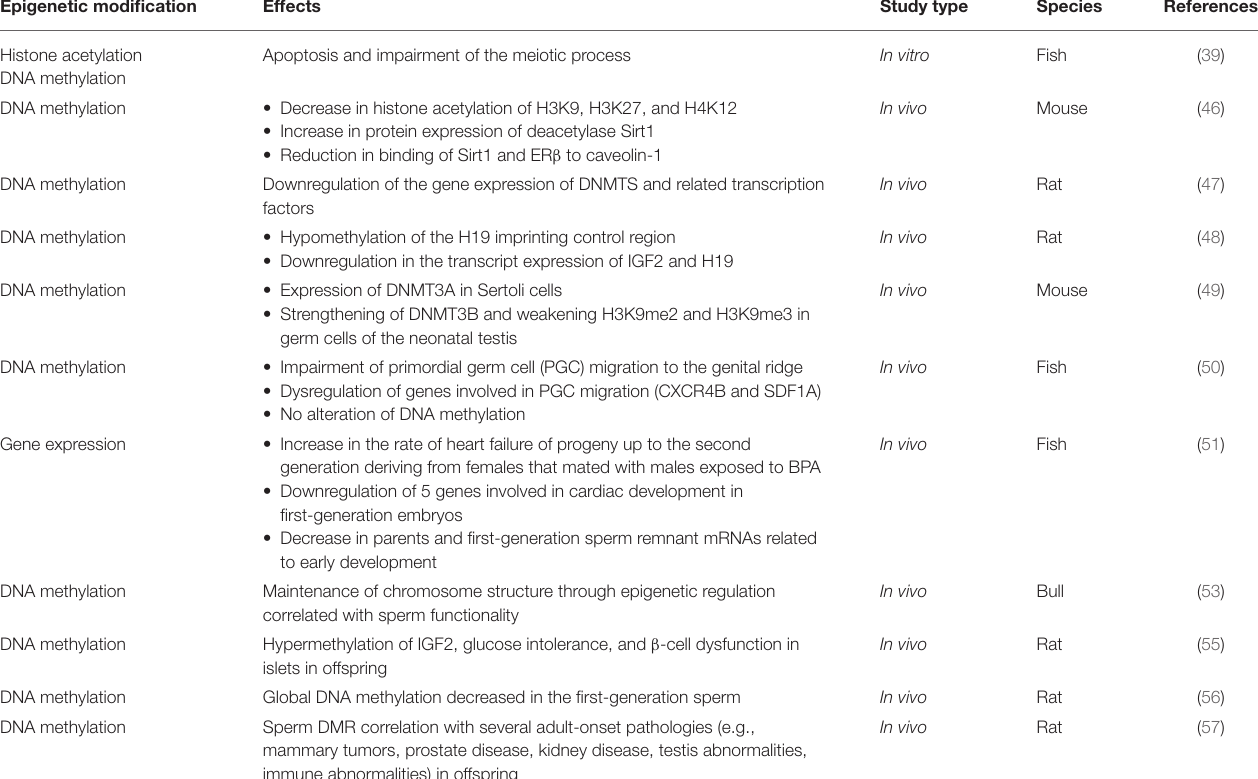
TABLE 5 | Characteristics of the studies which analyzed the transgenerational effects of BPA exposure.